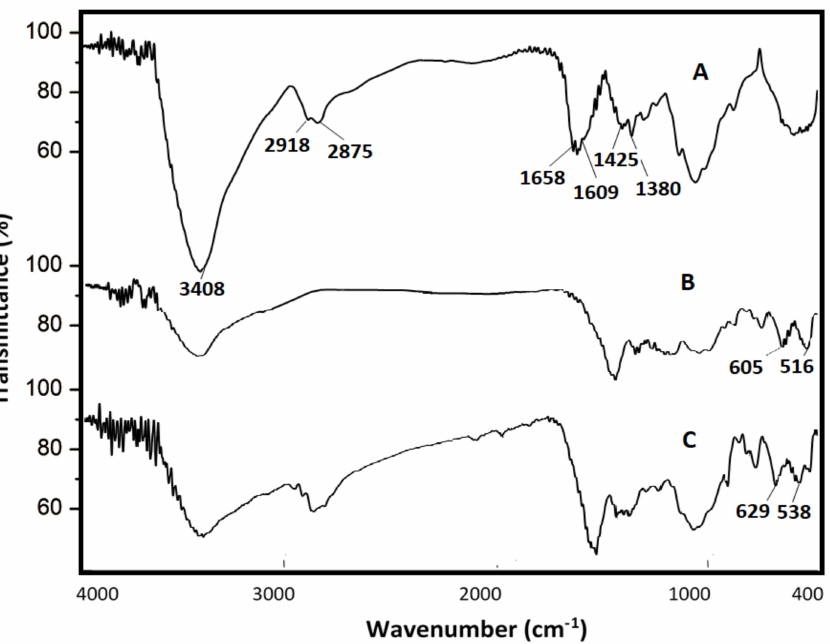
Figure 2. FTIR of ( A ) chitosan, ( B ) CaO nanoparticles, and ( C ) chitosan–CaO nanocomposites (15